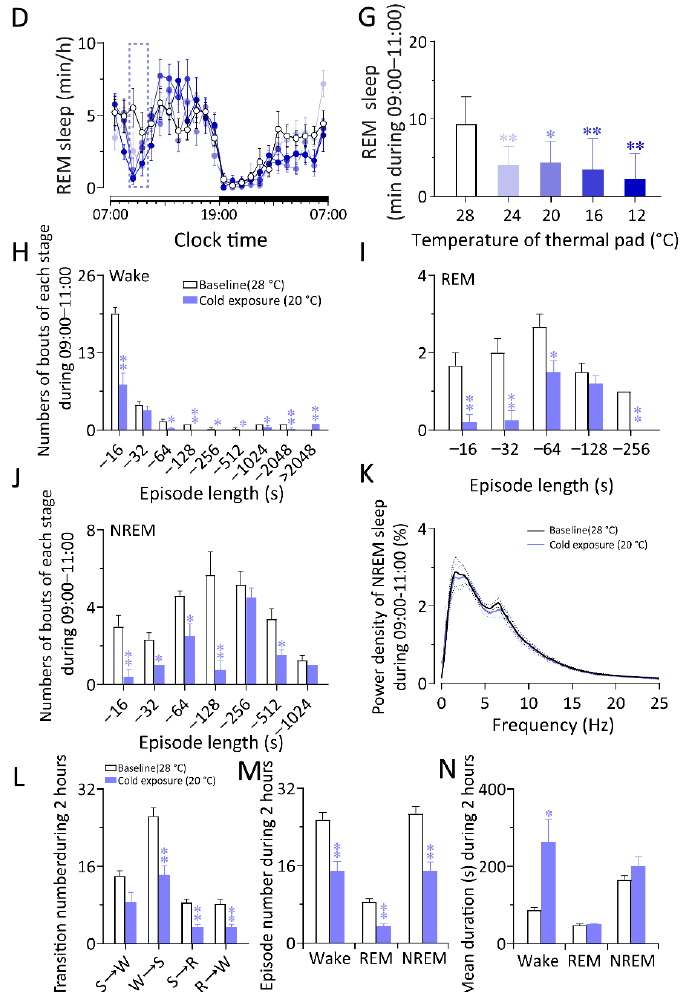
Figure 1. Cold exposure increased wakefulness and decreased NREM and REM sleep in WT mice. ( A ) Schematic diagram of sleep recording and cold exposure. ( B – D ) 24 h time–course changes